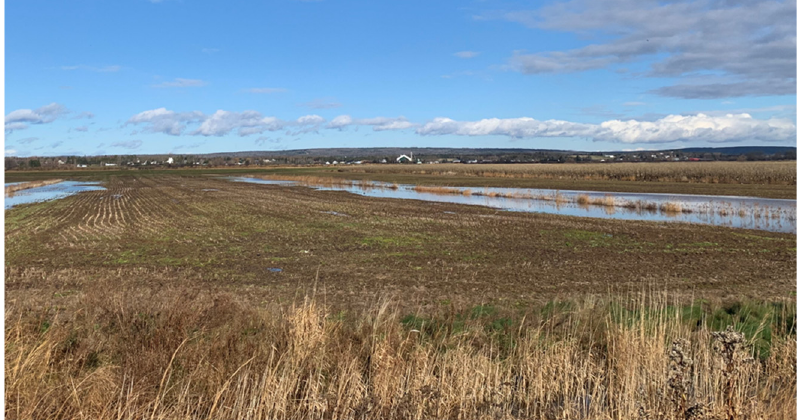
Figure 4. Dykeland field in Truro, Nova Scotia (45.3729°N, 63.2954°W) with water ‐ saturated areas. Image was captured on the morning of November 11, 2020.